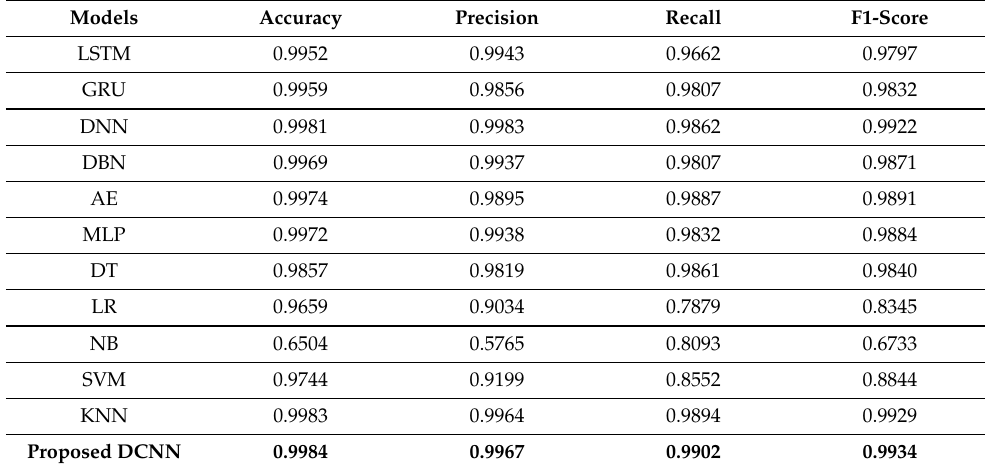
Table 8. A comparison of DCNN with other DL models on binary-class.